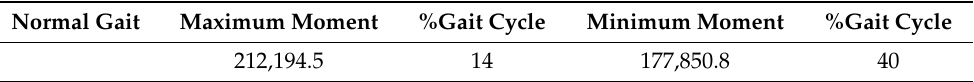
Table 5. Moment maximum, minimum, and their corresponding percentage occurrences within the normal gait